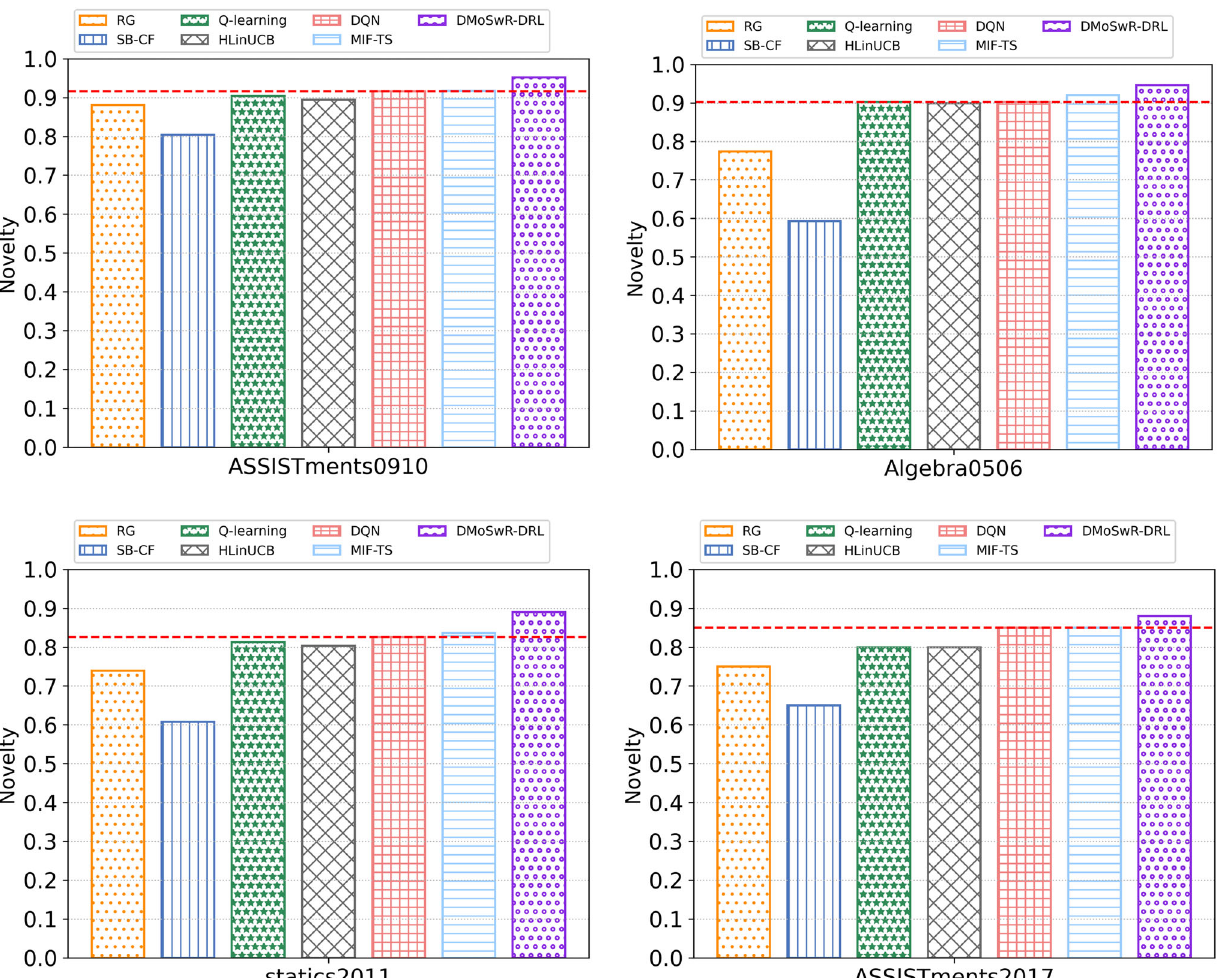
Fig. 8 Performance comparison of different models on four datasets in terms of novelty (red dotted line: